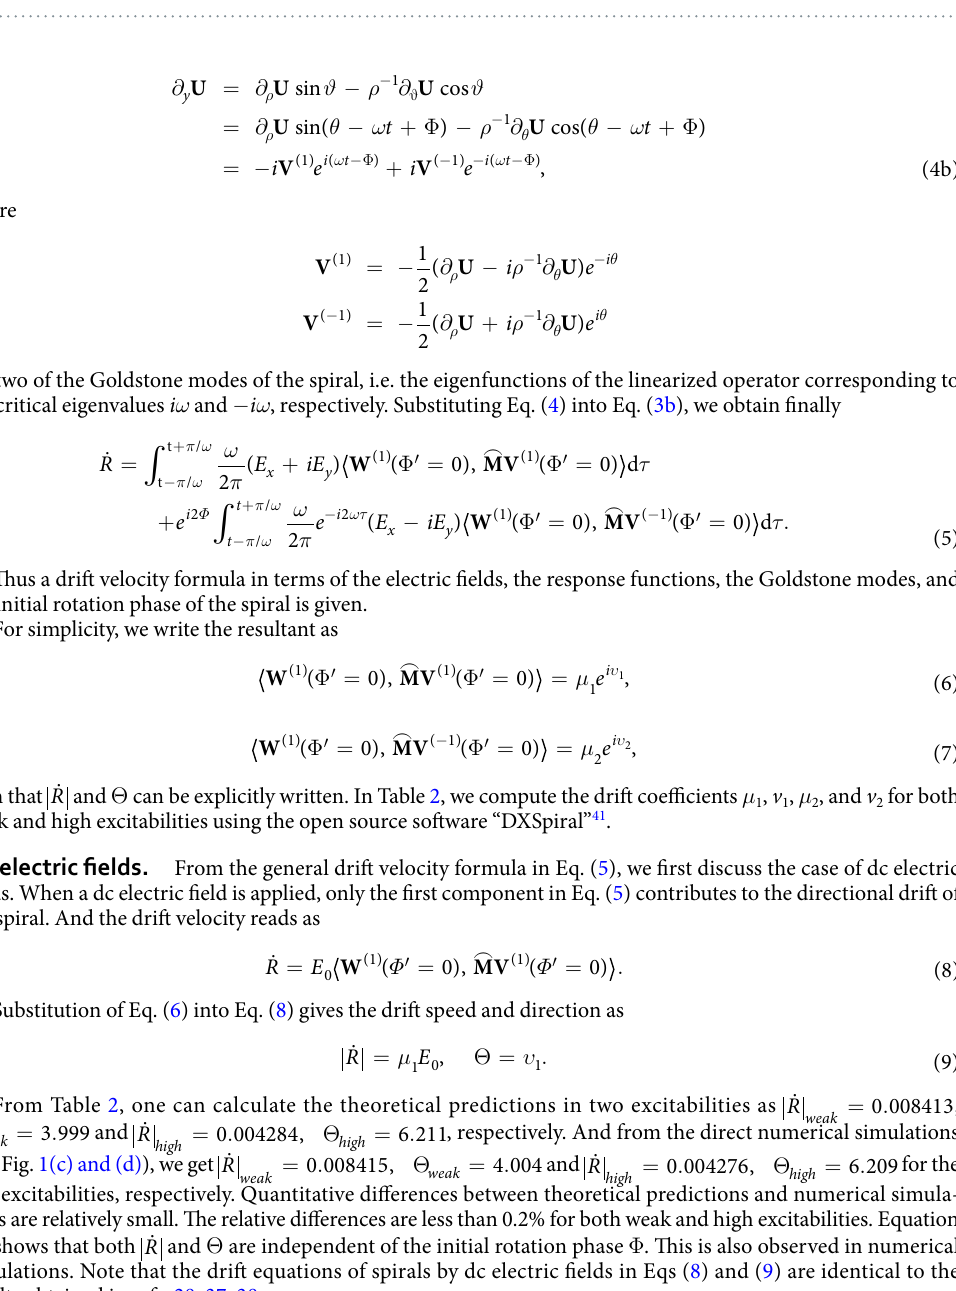
Table 2. Values of the drift